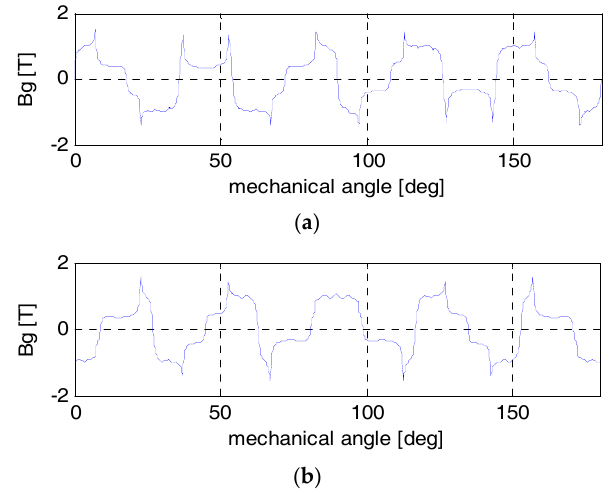
Figure 5. Air gap flux density of the vernier with rotor positions. ( a ) when θ m = 0°; ( b ) when θ m = 9°.